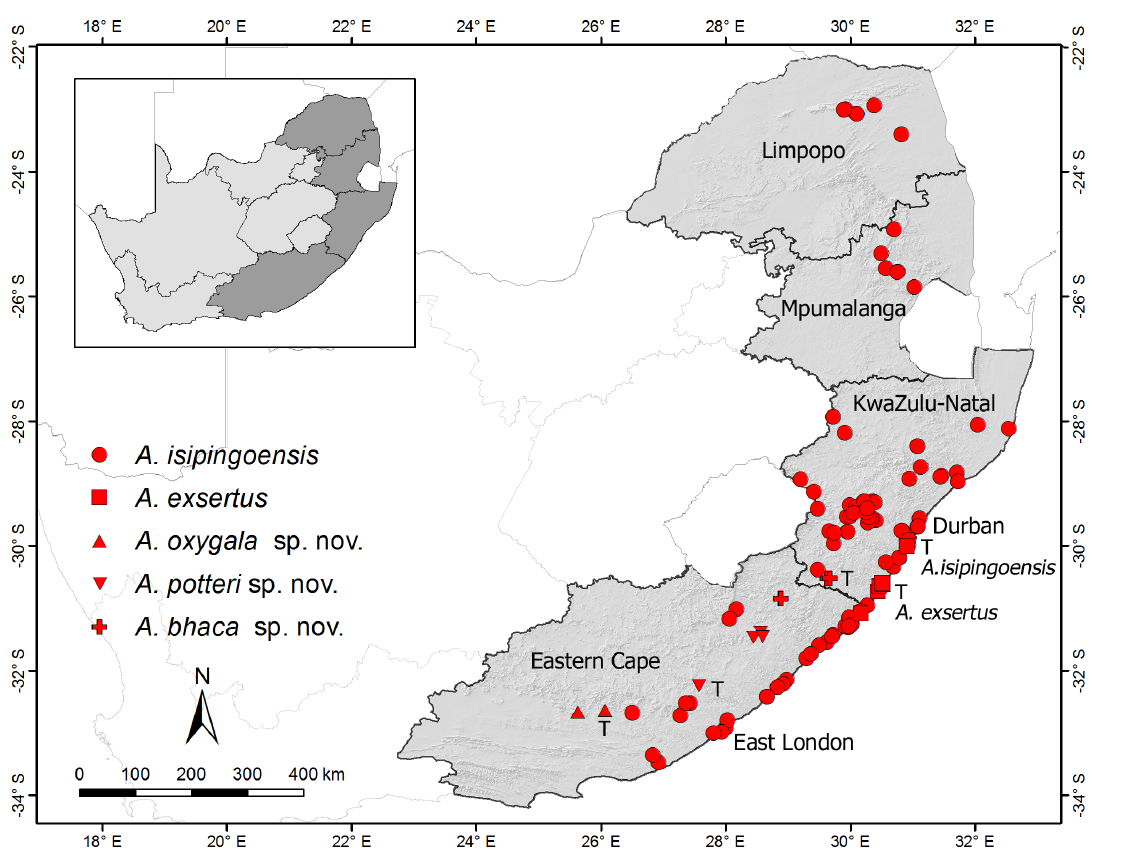
Fig. 29. Distribution map of Afrocyclus gen. nov. T indicates type localities. Provinces and major cities are